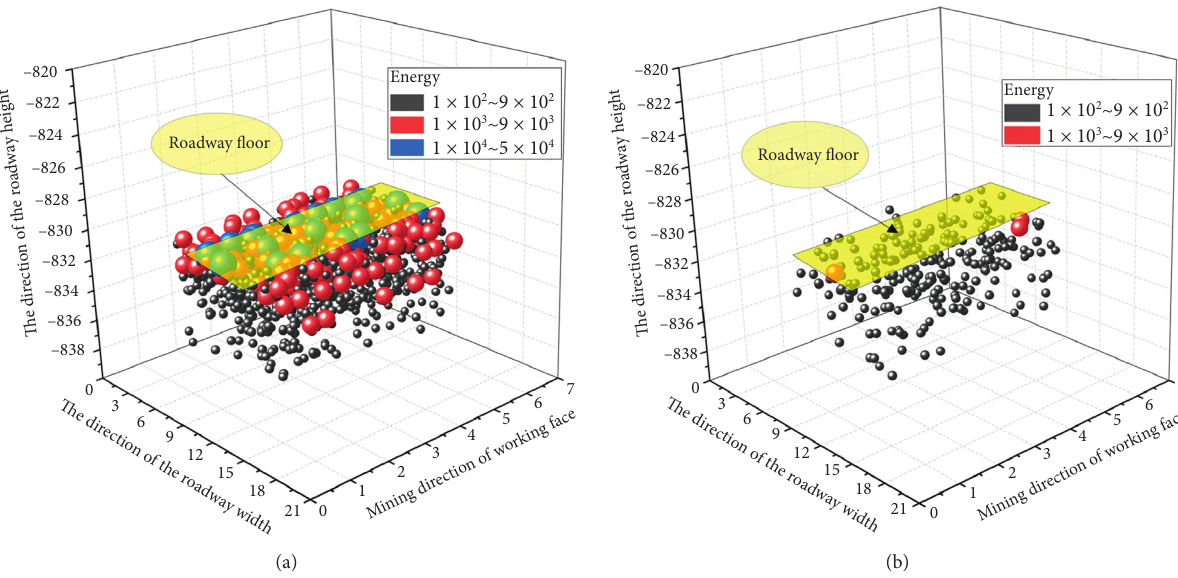
Figure 20: Three-dimensional microseismic events of the floor. (a) Floor without support. (b) Floor for pressure relief and